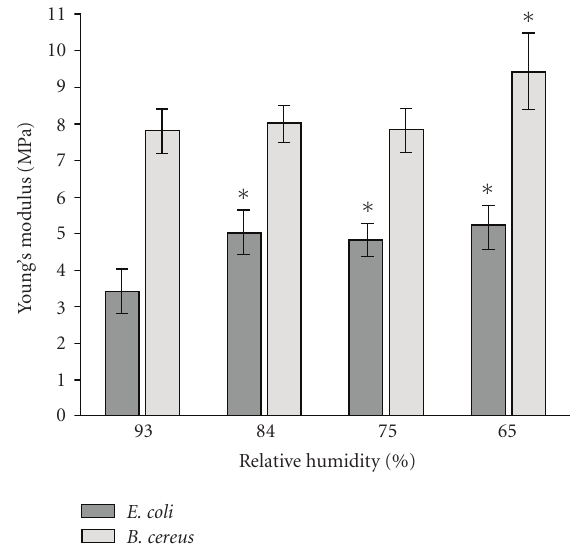
Figure 3: Diagram of Young’s modulus distribution; ∗ − P < . 05 (Wilcoxon’s signed-rank